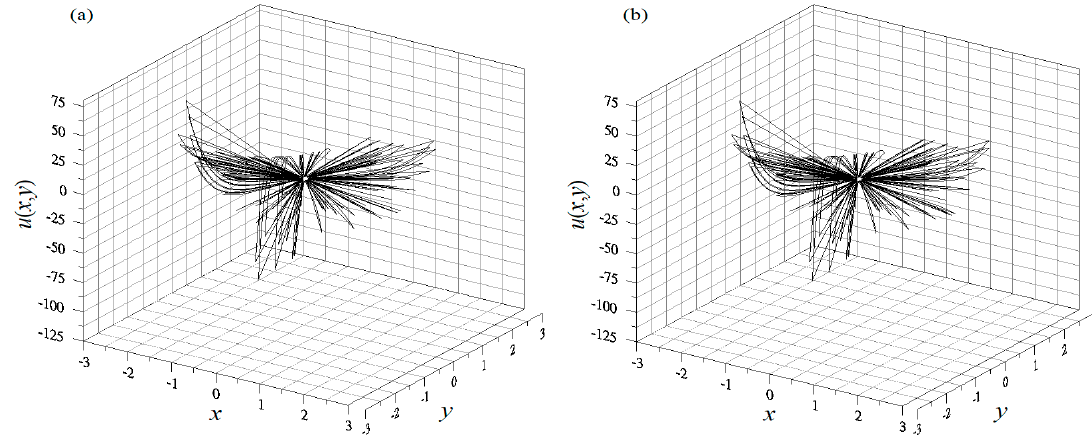
Figure 6. The exact solutions for the steady-state AC equation with gear irregular domain are shown in ( a ), and in ( b ) the proposed approach solution without random noise.